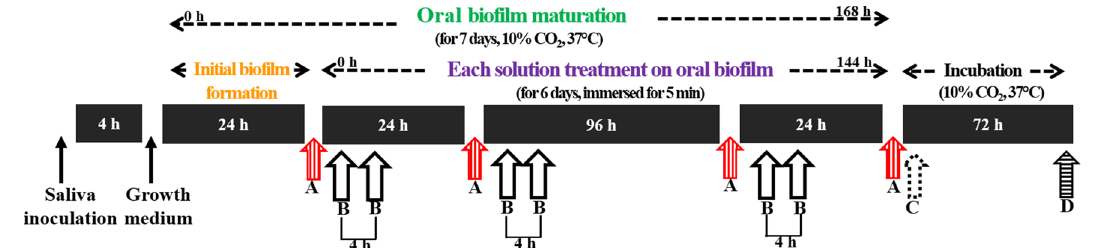
Figure 1. Flow chart of the experimental procedures. QLF-D quantitative light-induced fluorescence-digita, CEON cinnamon essential oil nanoemulsion, CHX chlorhexidine gluconate, CB cocamidopropyl betaine, CFUs colony-forming units. A: QLF-D analysis. B: Treatment of oral biofilms with 5% CEON, 0.12% CHX, or 0.5% CB. C: Harvest and absorbance measurement of oral biofilms. D: Assessment of aciduric bacteria